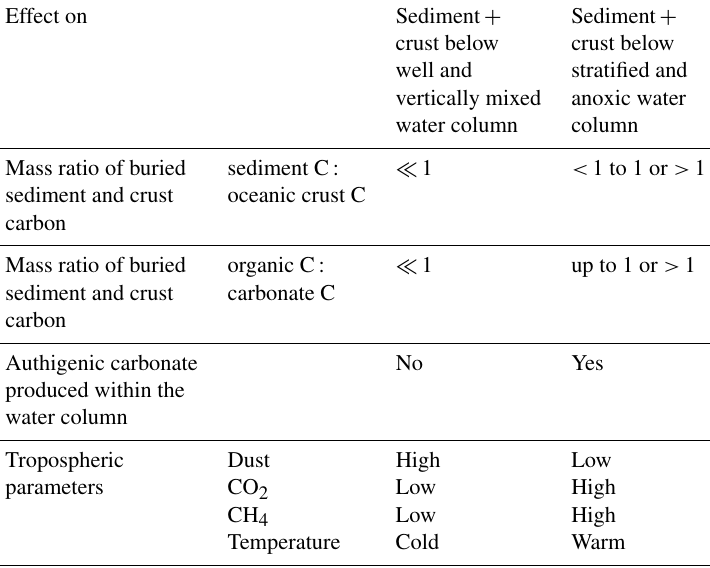
Table 2. Interglacial climate episodes were hot, nearly dust-free and had elevated levels of GHGs. The interglacials coincided with stratified water columns. The stratified ocean has much reduced activity due to the reduced CO 2 transport to the bottom of the ocean basin. As the O 2 transport is reduced and the lower part of the basin is anoxic, the oxidative mineralization of the organic litter fall from phytoplankton activity at the surface is reduced and generates sediments rich in organic substances. As sulfate, nitrate and in part CO 2 within the anoxic water column are reduced to sulfide, ammonium and CH 4 , the pH increases to alkaline. This can induce carbonate precipitation near the chemocline. During the glacial maxima with cold temperatures, dustiness and low greenhouse gas levels, the ocean basins had well and vertically mixed water columns with highest carbonate C burial and lowest organic C burial. Effect on Sediment + Sediment + crust below crust below well and stratified and vertically mixed anoxic water water column column Mass ratio of buried sediment C: (cid:28) 1 < 1 to 1 or > 1 sediment and crust oceanic crust C carbon Mass ratio of buried organic C: (cid:28) 1 up to 1 or >